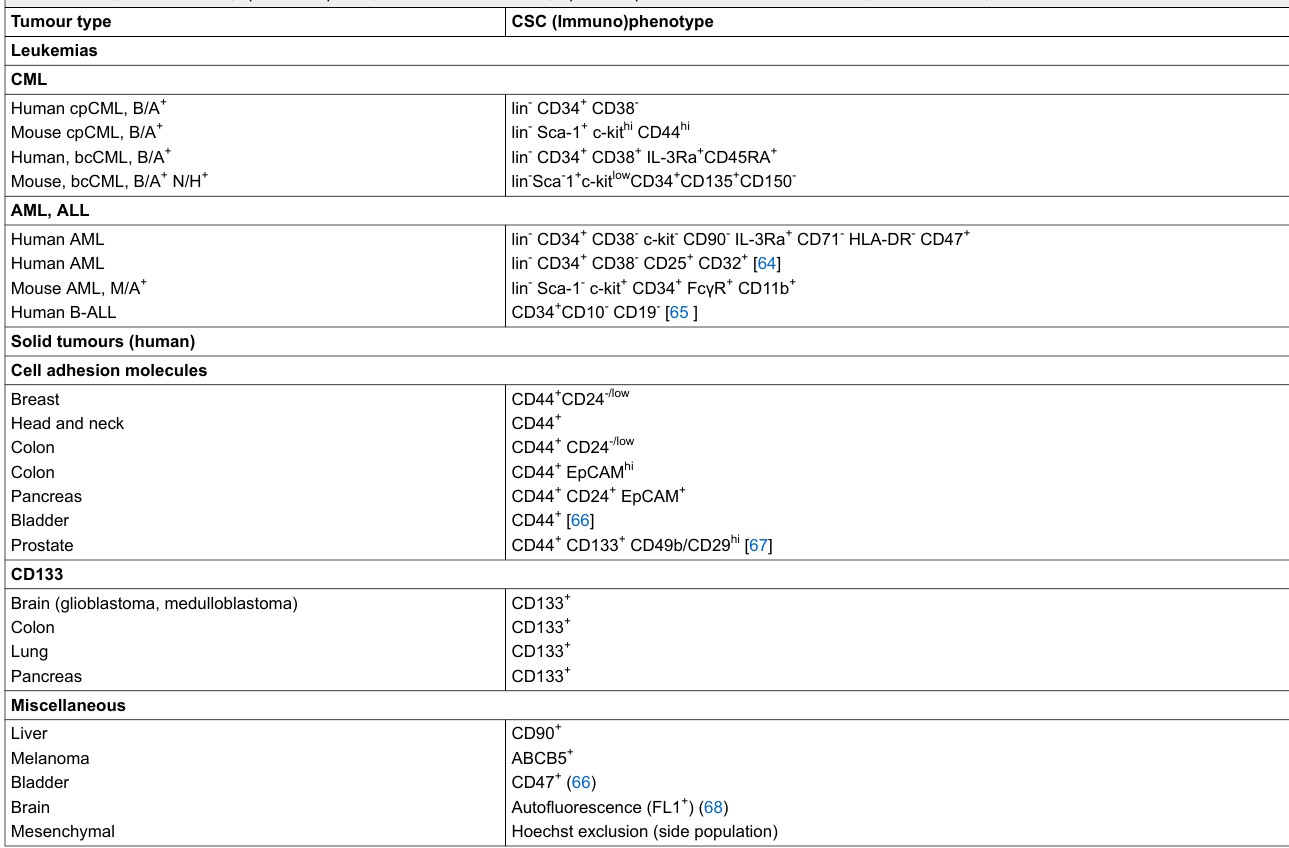
Table 1: Surface markers of cancer stem cells (adapted from Visvader JE, Lindeman GJ. Cancer stem cells in solid tumours: accumulating evidence and unresolved questions. Nat Rev. Cancer. 2008;8:755–68 [44], and Krause DS, Van Etten RA. Right on target: eradicating leukemic stem cells. Trends Mol Med. 2007;13:470–81 [69]). B/A: BcR/ABL; bc: blast crisis; cp: chronic phase; CSC: cancer stem cell; EpCAM: epithelial cell adhesion molecule; M/A: MLL/AF9; N/H: NUP98/HOXA9. Tumour